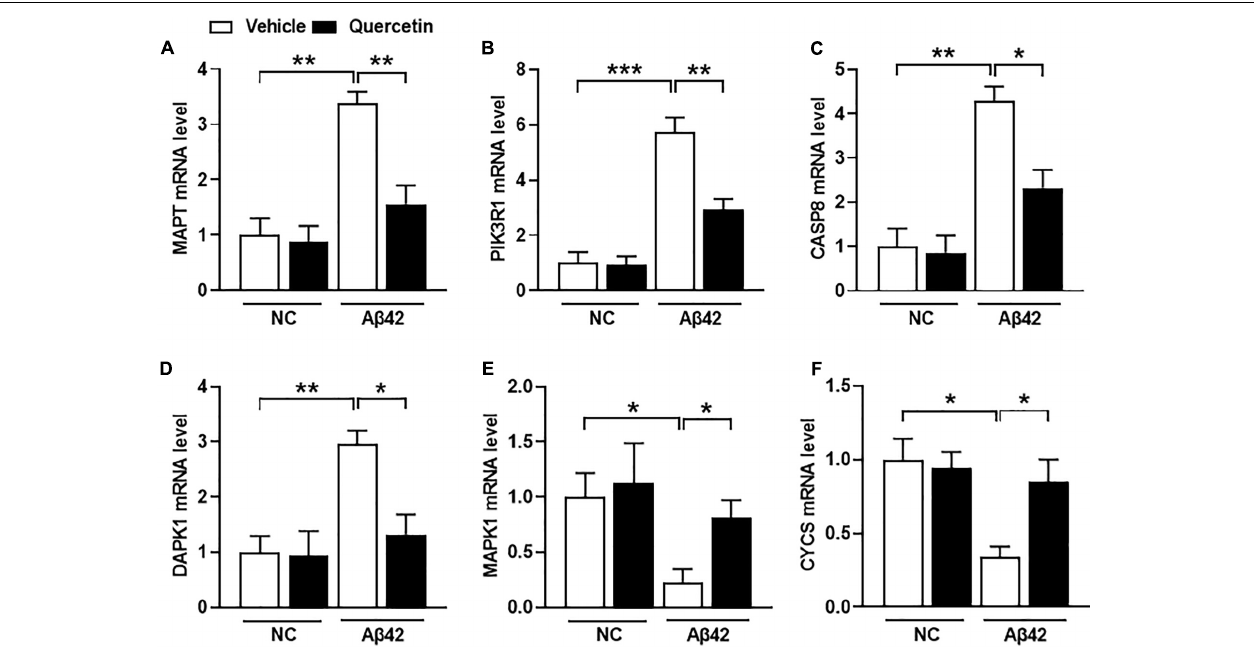
FIGURE 8 | The quercetin potential target genes among different groups of HT22 cells by quantitative polymerase chain reaction (qPCR) analysis. The mRNA level of MAPT (A) , PIK3R1 (B) , CASP8 (C) , DAPK1 (D) , MAPK1 (E) , and CYCS (F) in different treatment groups. Data were normalized to β -actin, and values are presented as mean ± SEM ( n = 5 in each group). ∗ p < 0.05, ∗∗ p < 0.01, ∗∗∗ p < 0.001.